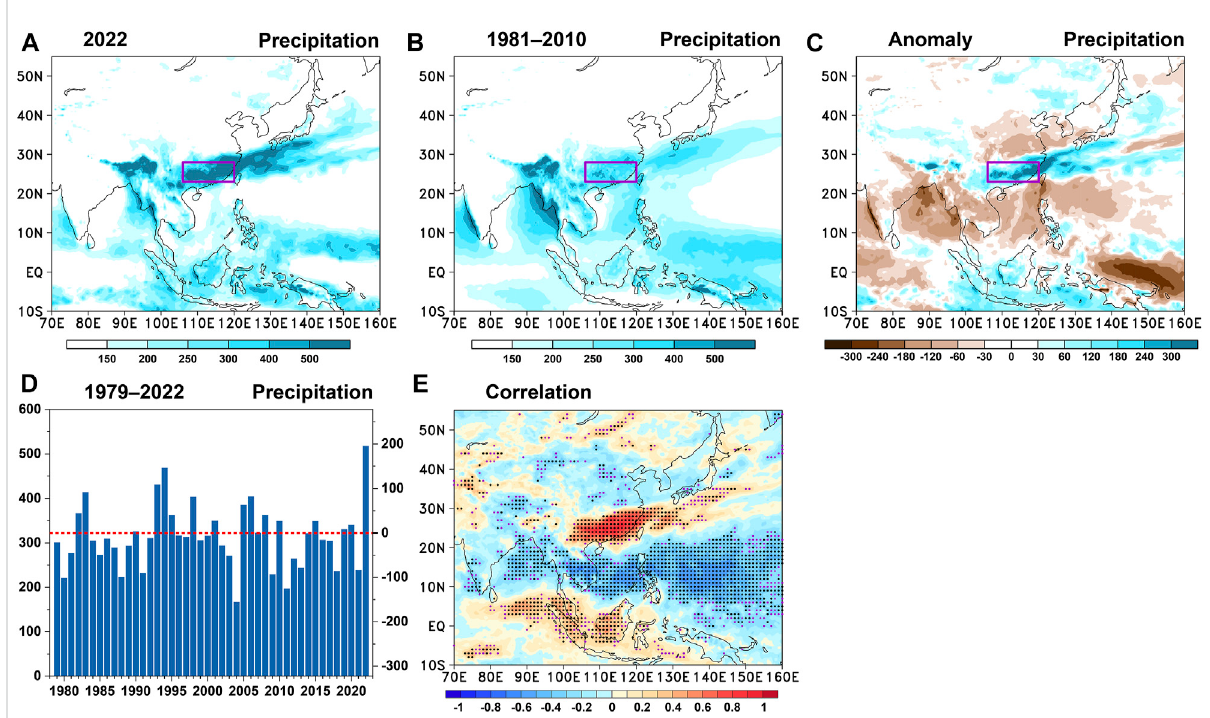
FIGURE 1 (A) Distribution of the accumulated rainfall during the “ Dragon Boat Water ” season (21 May to 20 June) in 2022; (B) and (C) are the same as (A) but for the climatological rainfall during 1981 – 2010 and the rainfall anomaly in 2022, respectively. The rainfall anomaly is calculated by subtracting the climatological rainfall during 1981 – 2010. The purple box in (A – C) represents the region of South China (SC; 106 ° E – 120 ° E, 23 ° N – 28 ° N). (D) Time seriesoftheregionallyaveragedrainfalloverSCduring1979 – 2022.TheY-axisontheleft(right)representstherainfall(rainfallanomaly).Thered dashed line represents theclimatological rainfall (zero line of rainfall anomaly)for theY-axis on theleft(right). (E) Correlation between theregionally averaged rainfall anomaly over SC and the rainfall anomaly during 1979 – 2022. Black (purple) dots over the shading represent that those